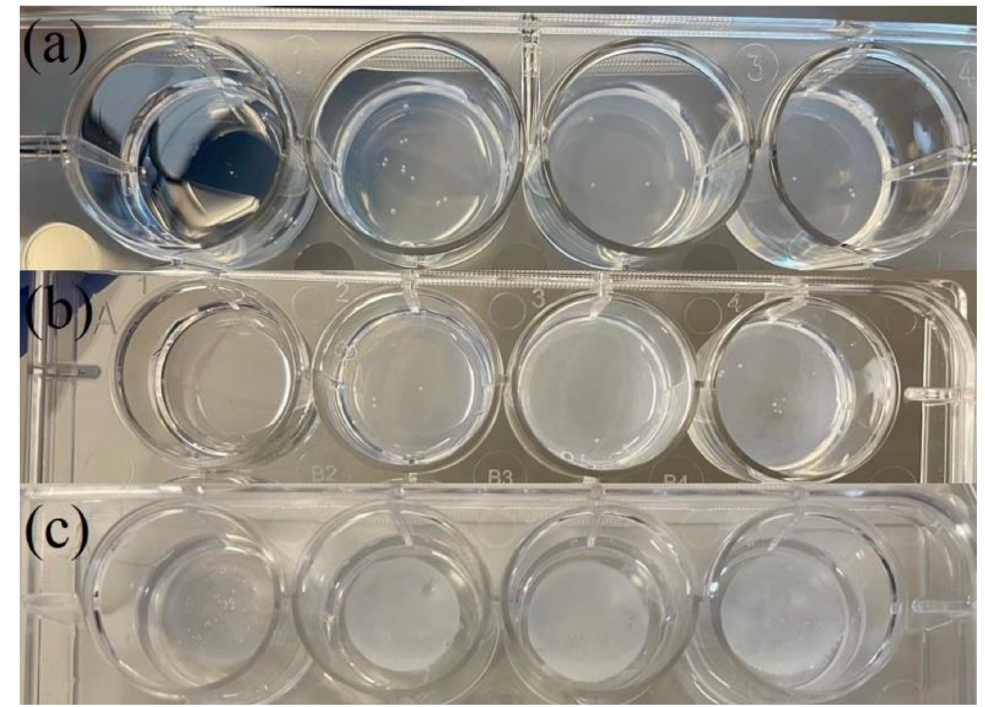
Figure 1. Macroscopic images of at the different stages of the synthetic process: ( a ) acidic mix- ture (pH 3.6) left at 37 ◦ C overnight, ( b ) after washing with citrate solution (pH 7.2) to neutral pH and ( c ) after incubation with thrombin in citrate at 37 ◦ C overnight. Final concentrations: fibrinogen = 20 mg.mL − 1 , collagen (from left to right) = 0, 2.5, 5, 10 mg.mL − 1